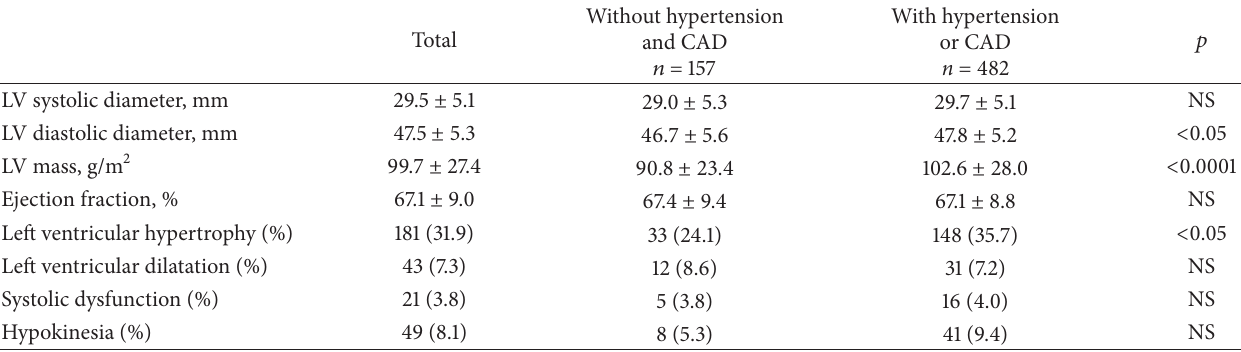
Table 2: Echocardiographic findings of the total cohort of type 2 diabetic patients, of those without hypertension and coronary artery disease, and of those with hypertension or coronary artery